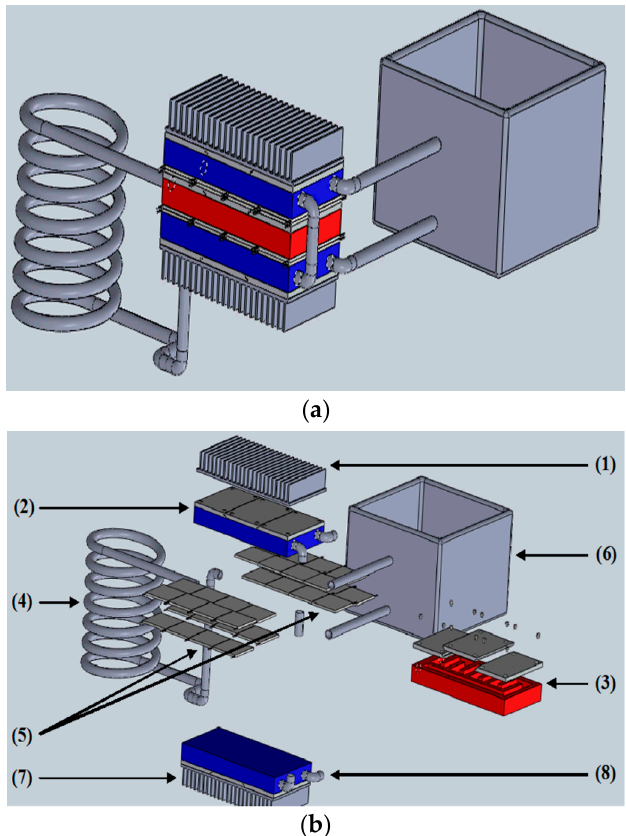
Figure 1. Design of the proposed ( a ) and demonstrated parts and pieces of the generator prototype ( b ).